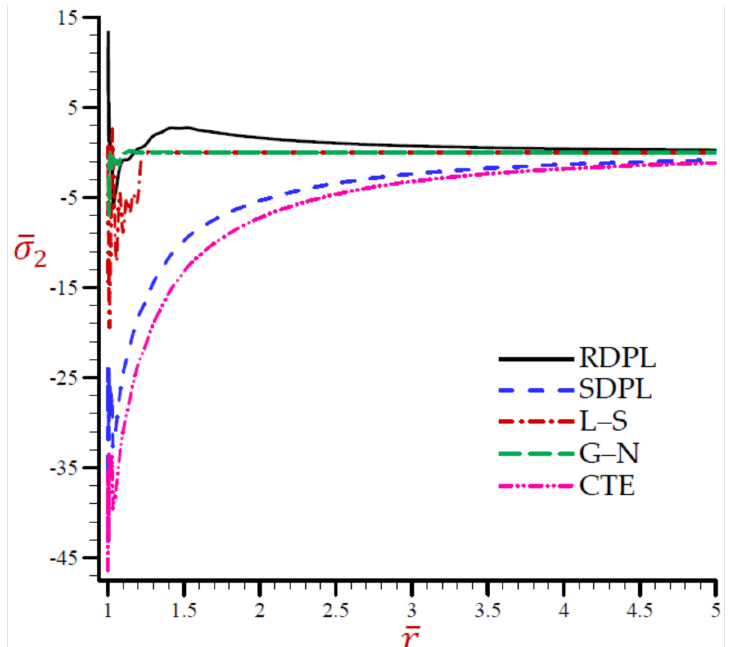
Figure 5. The hoop stress σ 2 across the radial direction of the cylindrical cavity conferring to all